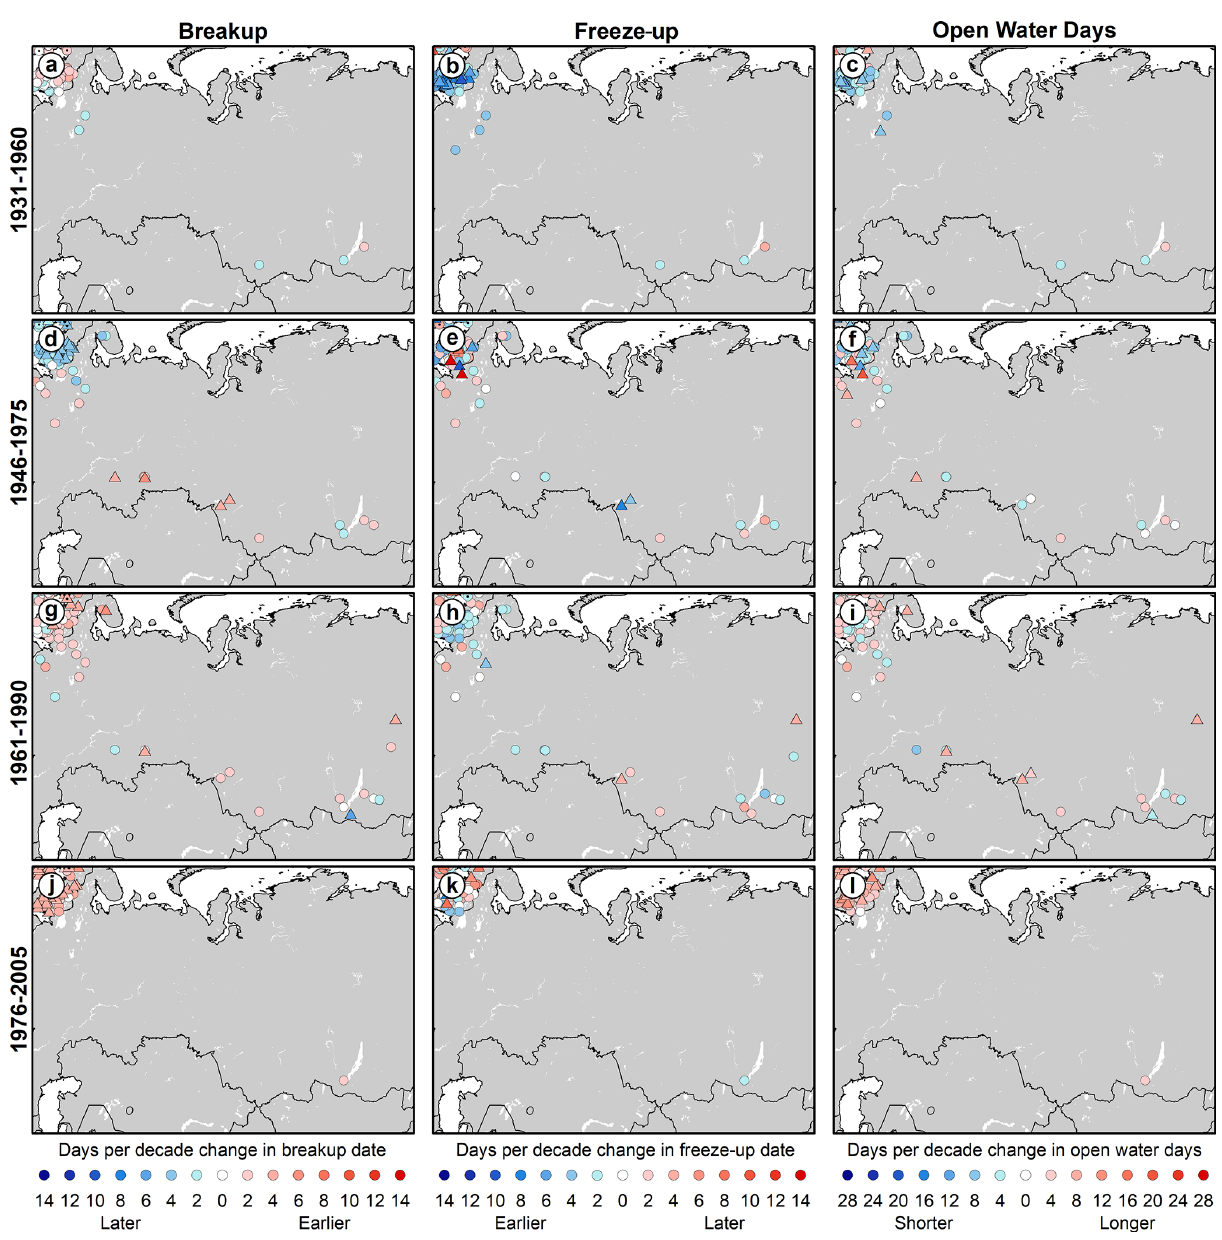
Figure 6. Decadal trends for breakup (a, d, g, j) , freeze-up (b, e, h, k) , and the number of annual open-water days (c, f, i, l) in Russia for the four individual time periods. The trend directions and magnitudes were derived from the Mann–Kendall and Sen’s slope tests. The triangles and circles indicate whether the trend was or was not statistically significant. Sites with a dot in the centre of the circle are river sites. Thus, a red triangle symbol with a dot in the middle indicates a river site that has a statistically significant warming trend over that time period. The blue and red tones on the scales are related to cooling and warming trends, respectively. Note that in some places the symbols